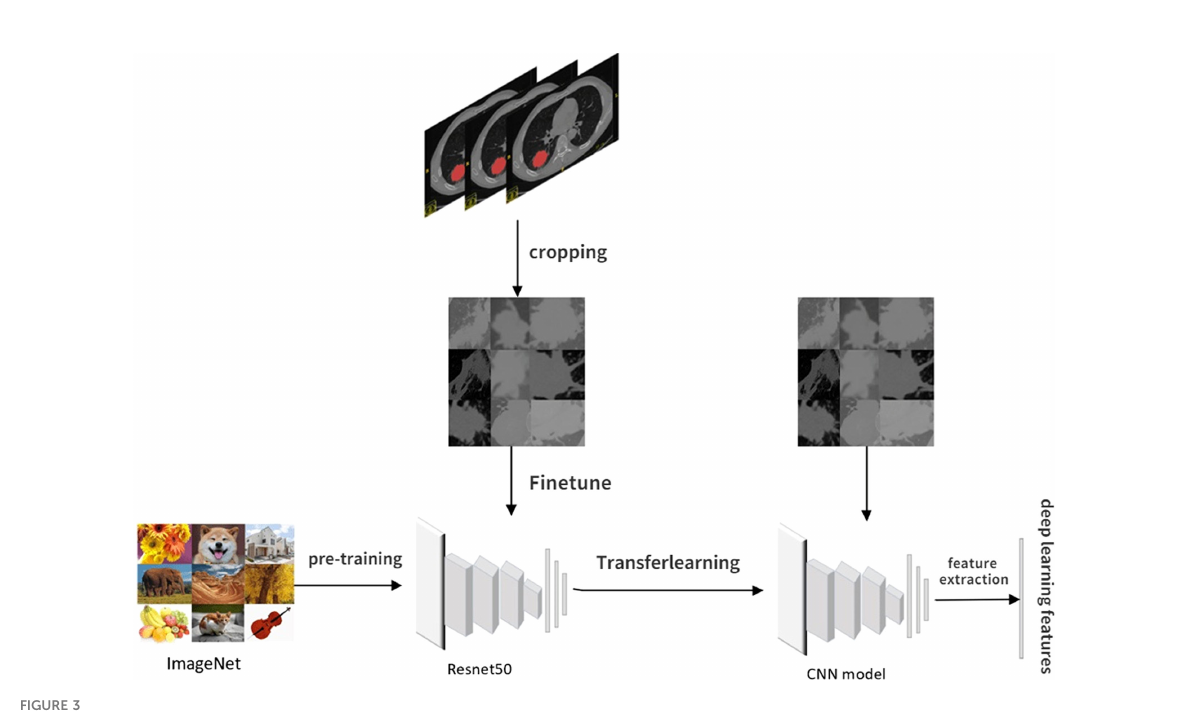
FIGURE 3 Flowchart of deep learning feature